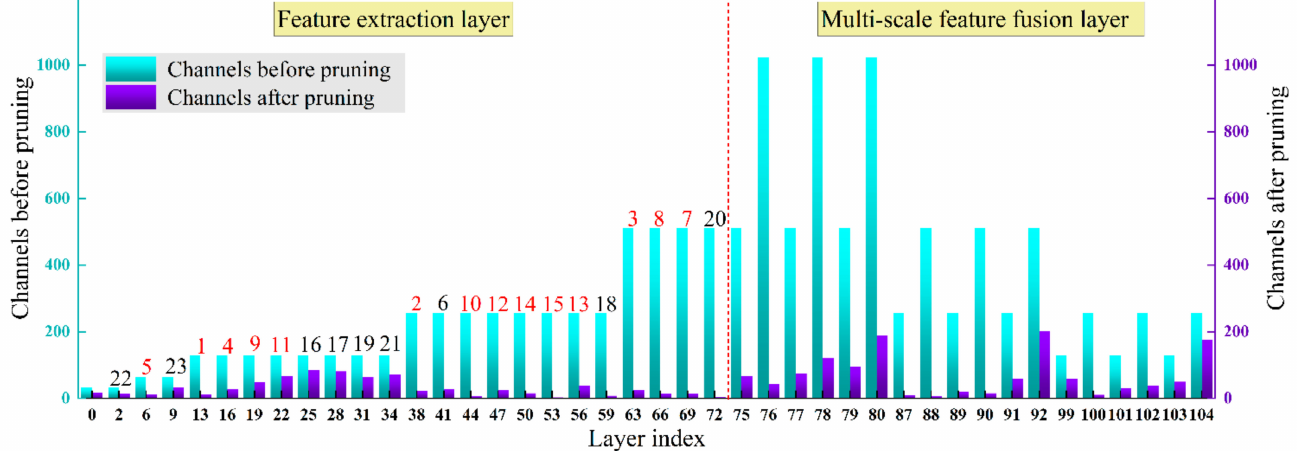
Figure 9. Channels and network layers change before and after